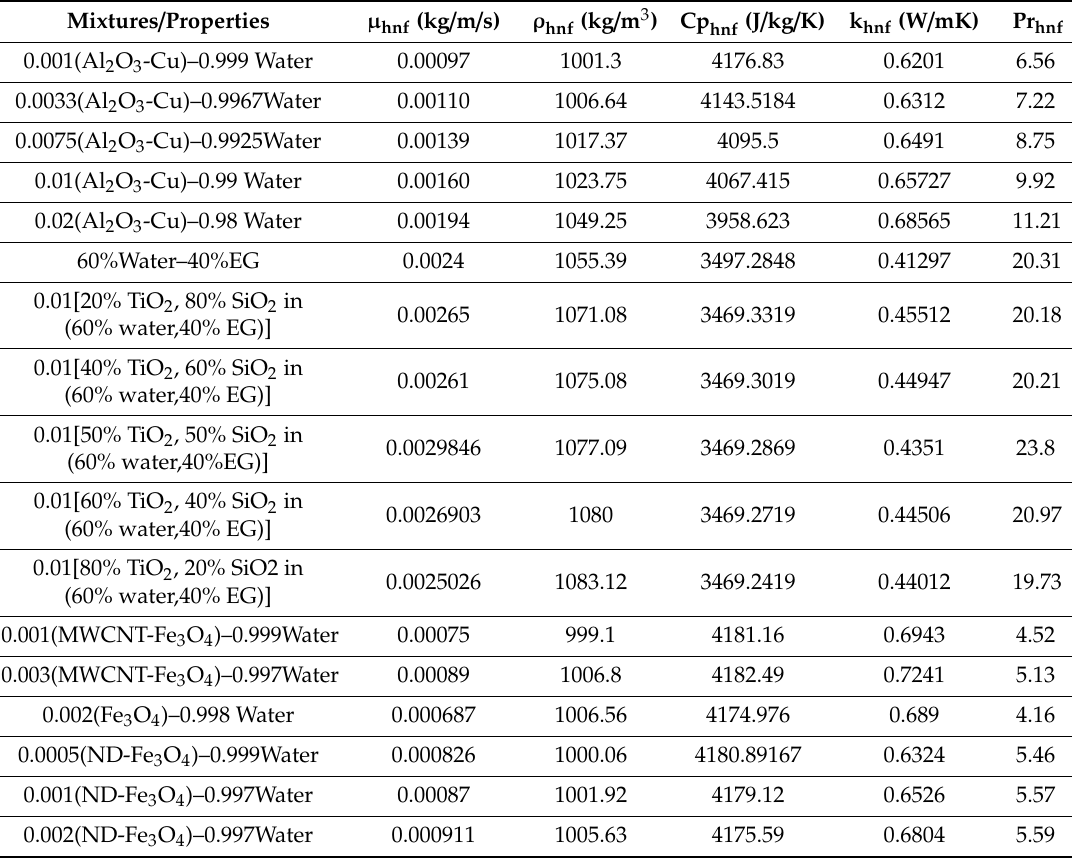
Table2. PhysicalpropertiesofhybridfluidsatT = 30 ◦ C[12,16–18]. Reproducedfrom[12], Elsevier:2011; Reproduced from [16], Elsevier: 2016; Reproduced from [17], Elsevier: 2017; Reproduced from [18], Elsevier: